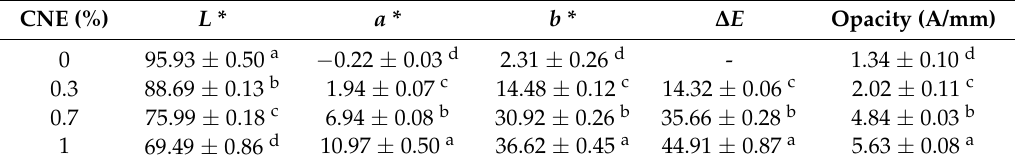
Table 2. Optical properties of ABS films containing various amounts of cocoa nibs